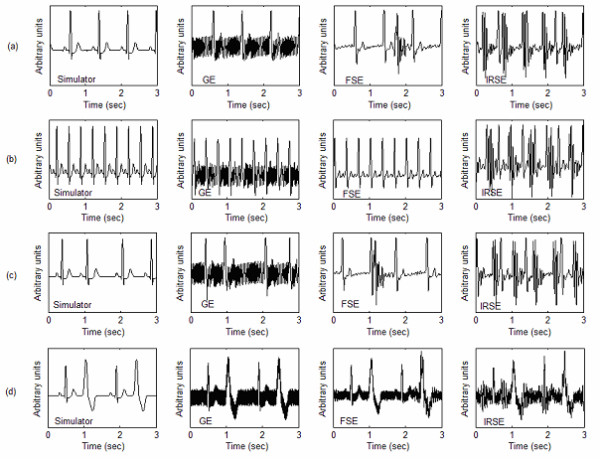
Simulated ECG recorded before and after contamination. (a)75 bpm (b)180 bpm (c)Sinus Arrythmia (d) Bigeminy.